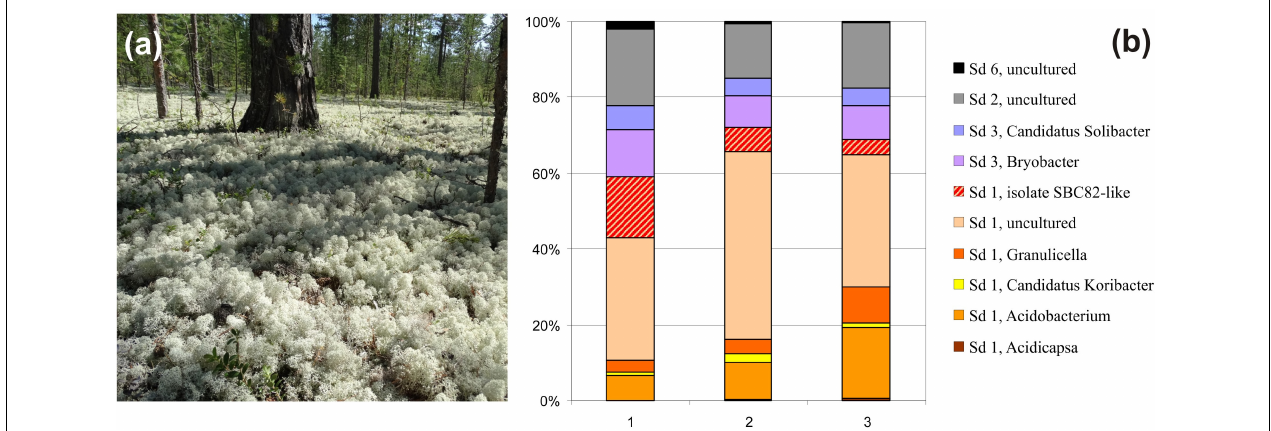
FIGURE 1 | (a) The forested tundra site examined in this study: pine forest with ground vegetation cover composed of reindeer lichens. (b) Community composition of the Acidobacteria within three individual plots of the forested tundra based on Illumina paired-end sequencing of 16S rRNA gene fragments. The proportion of reads assigned to isolate SBS82-like bacteria was determined based on the sequence identity threshold of